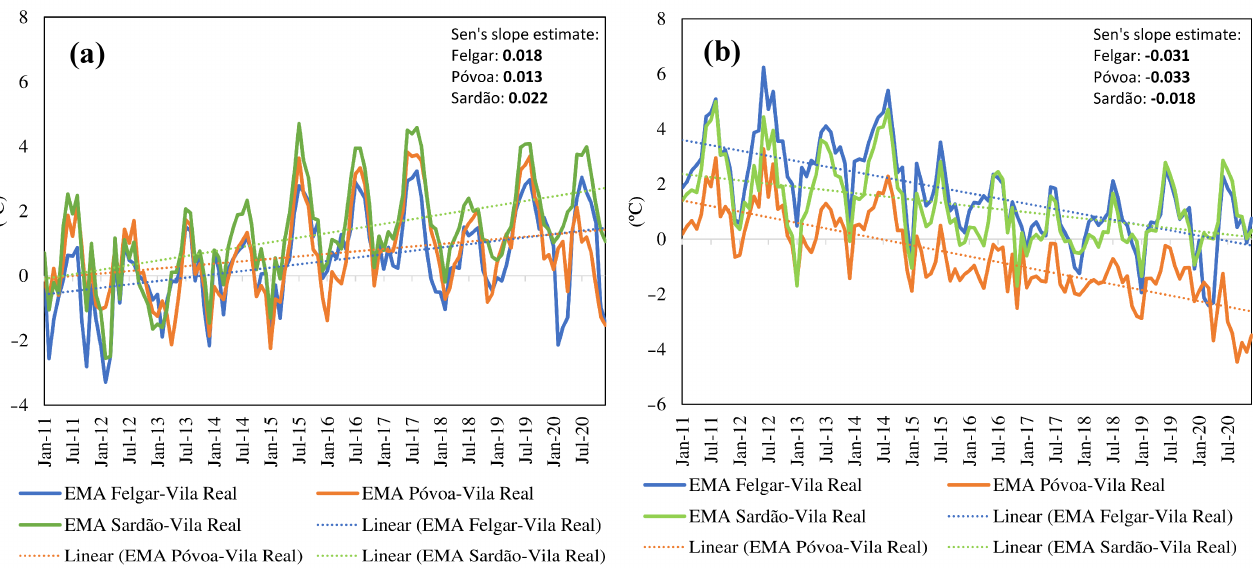
Figure 6. Monthly temperature anomalies trend between the AWS network stations and the Vila Real control station for the period 2011–2020: ( a ) minimum temperature and ( b ) maximum temperature.